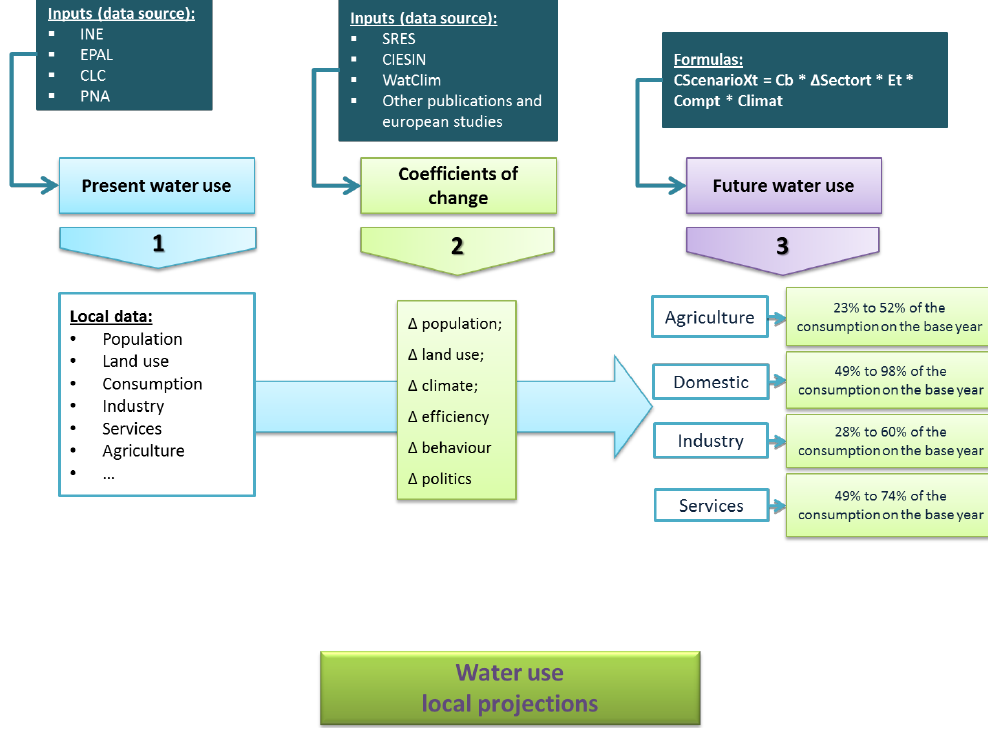
Figure 3 - Resumed methodology for water withdrawals projections. Source: Adaptaclima-EPAL